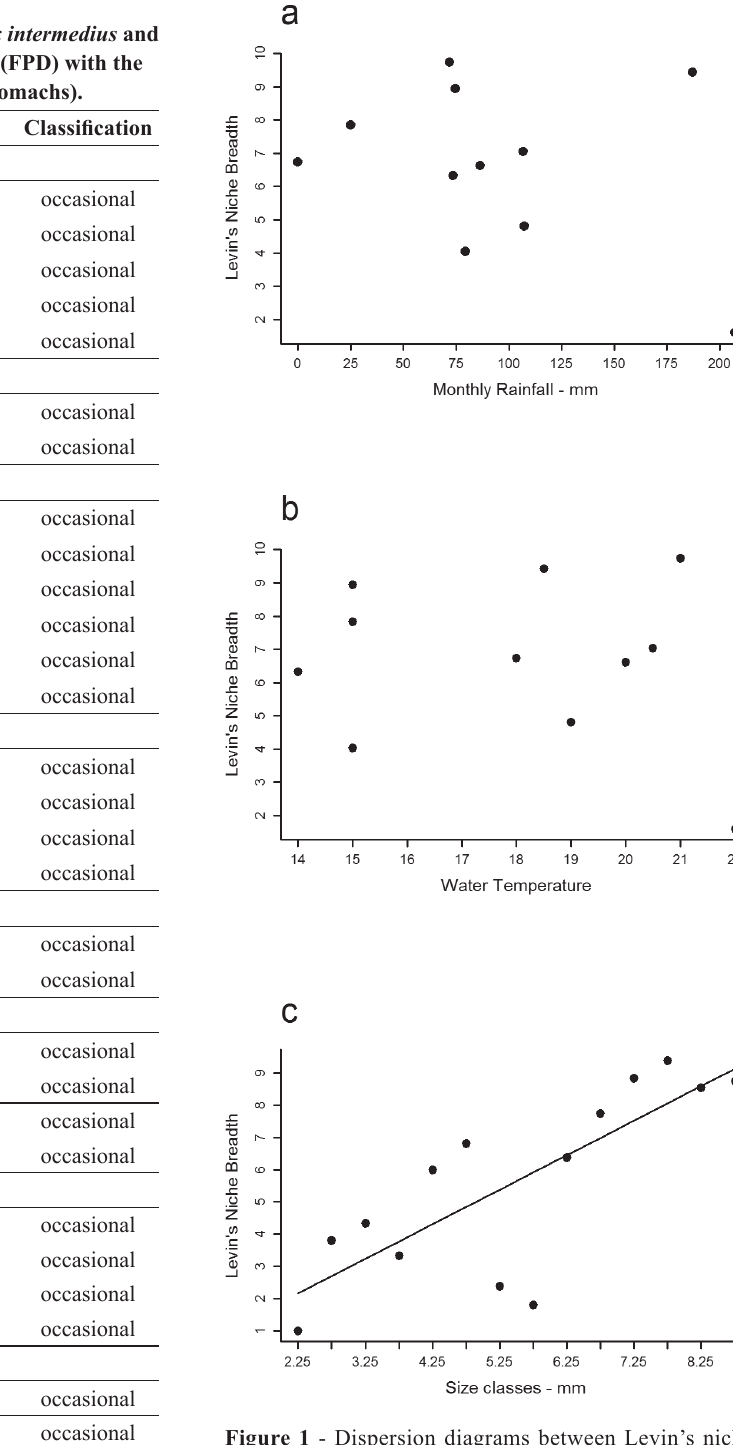
Figure 1 - Dispersion diagrams between Levin’s niche breadth and monthly rainfall ( a ), water temperature ( o C) ( b ), and size classes ( c ). The estimated values for regression parameters in c were: β = 0.001, r 2 =